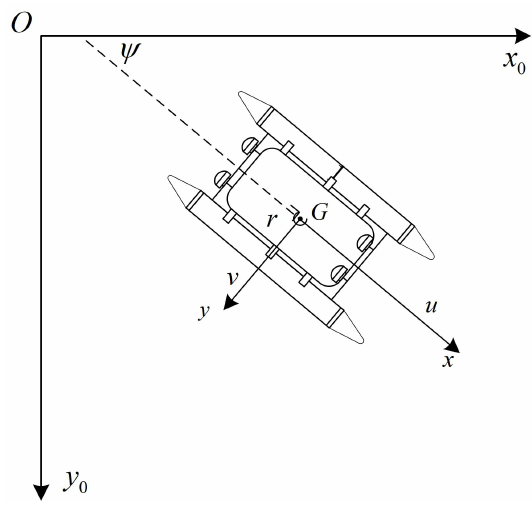
Figure 1. Ship motion coordinate